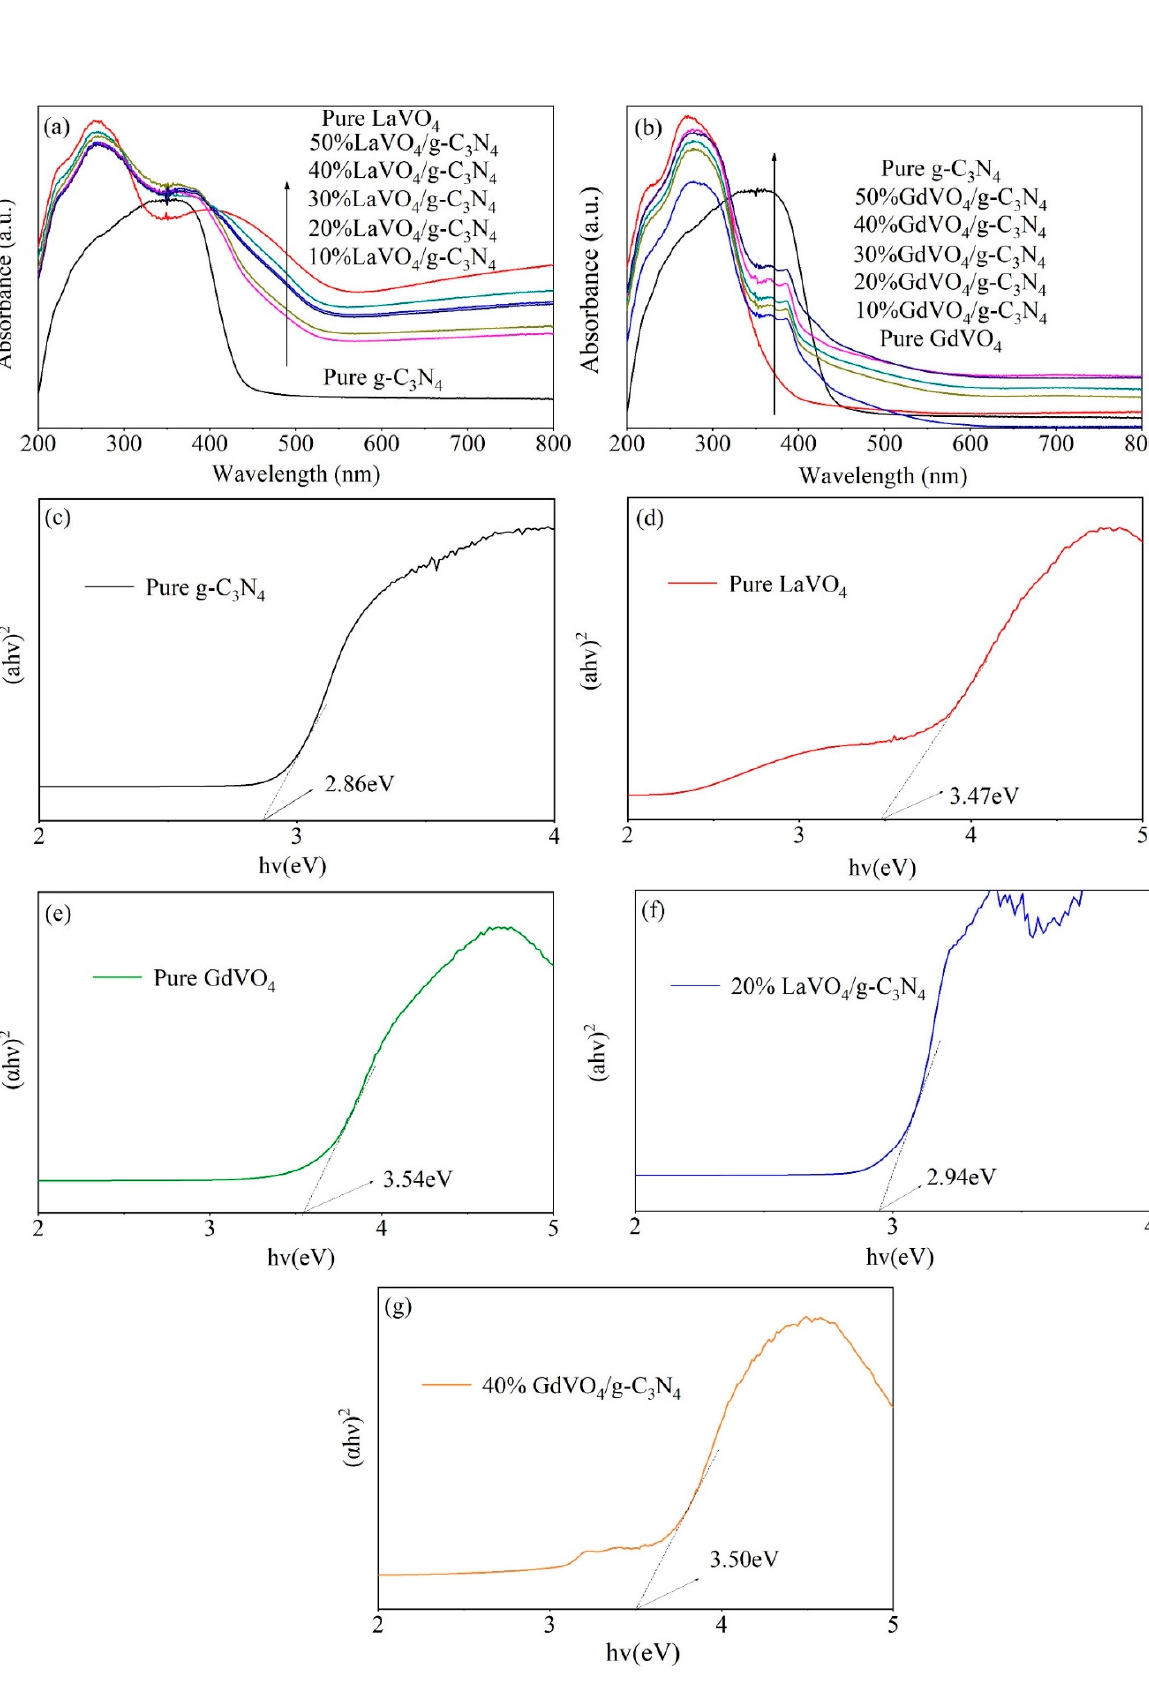
Figure 4. ( a ) XPS spectra of MVO 4 /g-C 3 N 4 (M = La, Gd) nanocomposites in a survey of the samples, ( b ) Gd 4d, ( c ) La 3d,